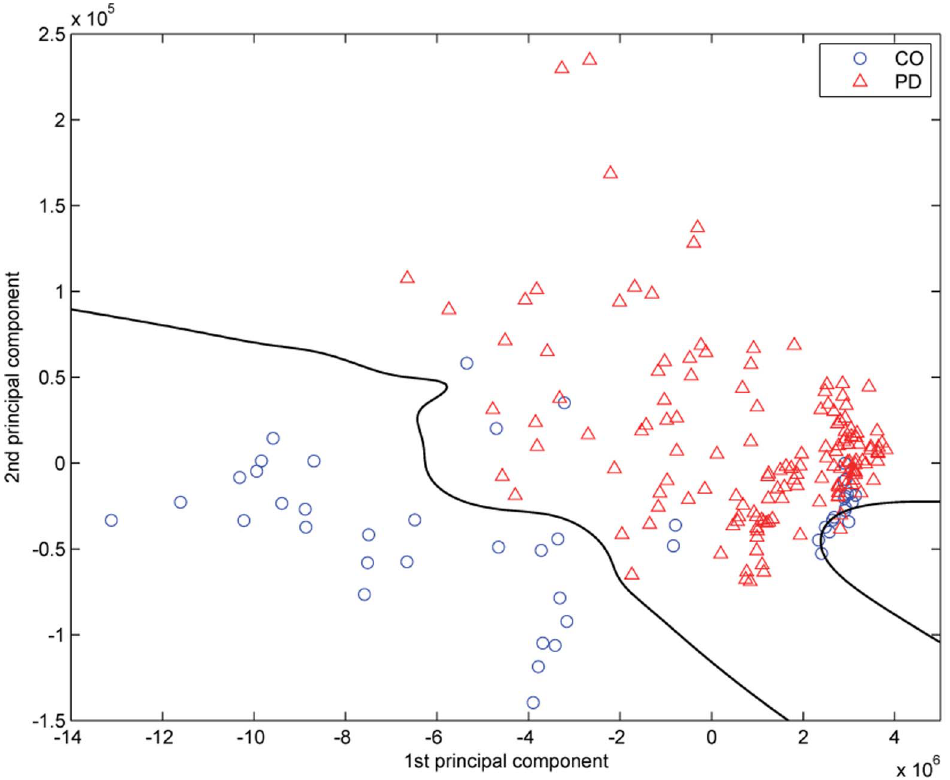
Figure 4. Scatter plots of the vocal patterns in the first and second kernel-based principal components plane for healthy controls (CO) and patients with Parkinson’s disease (PD). The decision boundary provided by the maximum a posteriori (MAP) classifier separates the vocal patterns associated with the CO and PD groups.